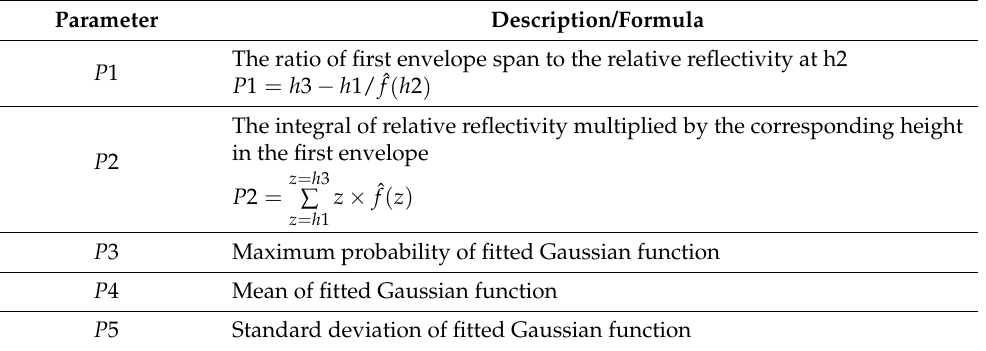
Table 2. Plot-level descriptors of mean relative reflectivity